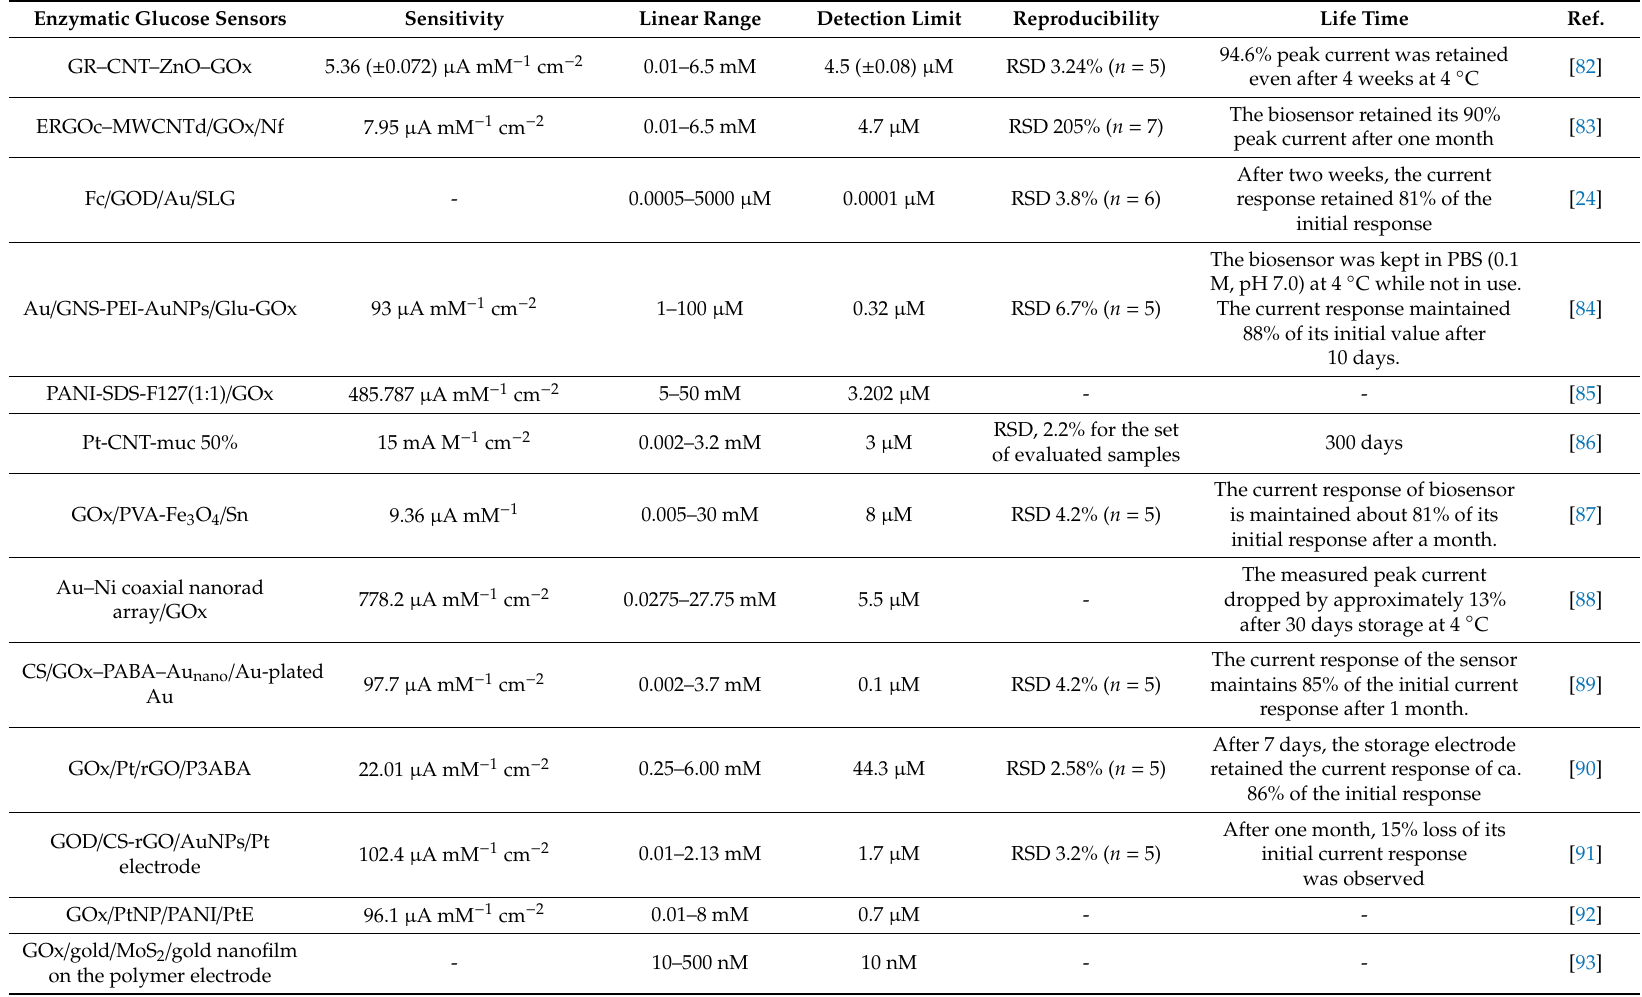
Table 1. Other nanomaterials, polymer based enzymatic glucose